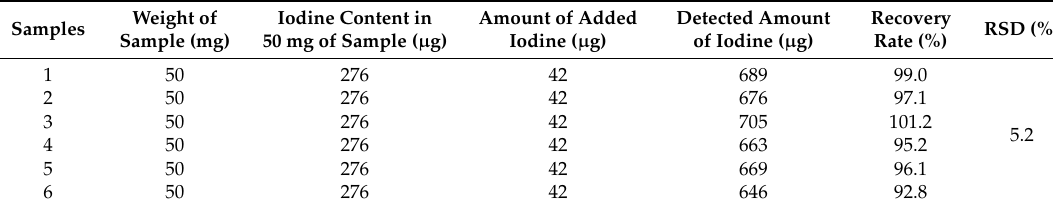
Table 6. The results of sample recovery rate.